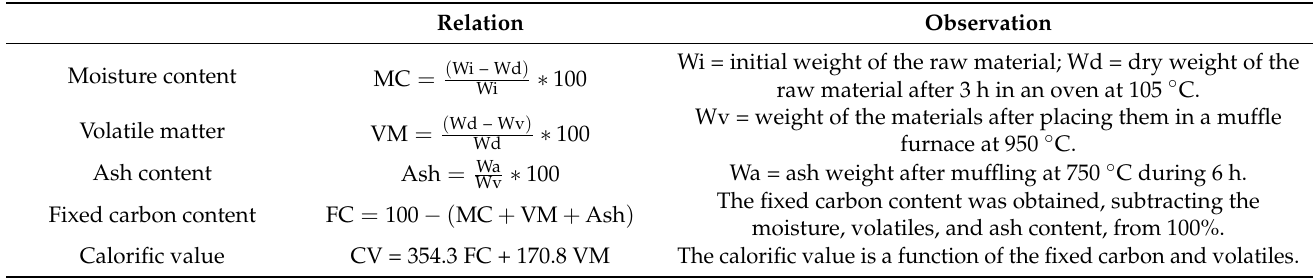
Table 1. Parameters analyzed according to the ASTM